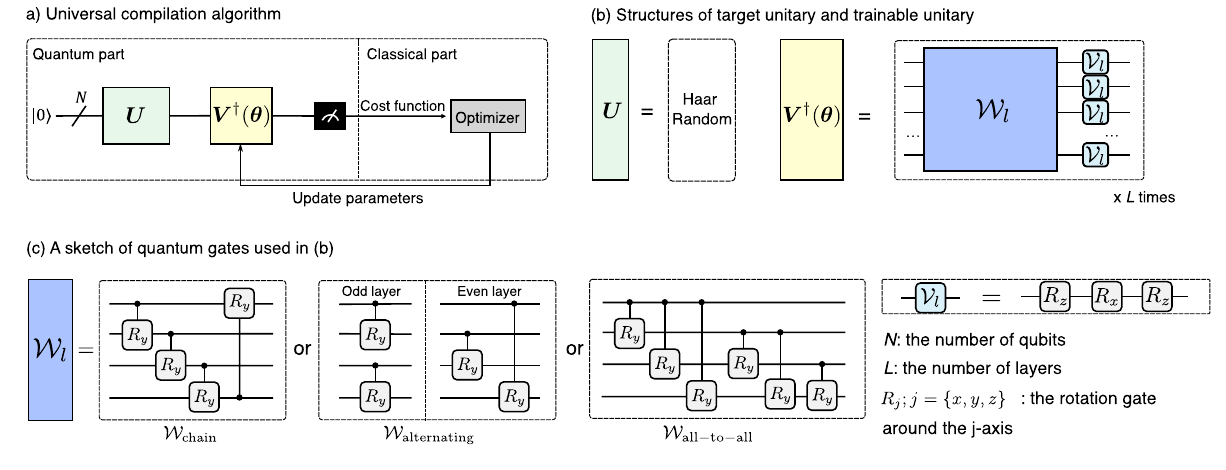
Figure 1. Universal compilation-based quantum state tomography. ( a ) A universal compilation algorithm consists of a quantum part and a classical part. In the quantum part, a final state is created by applying a set